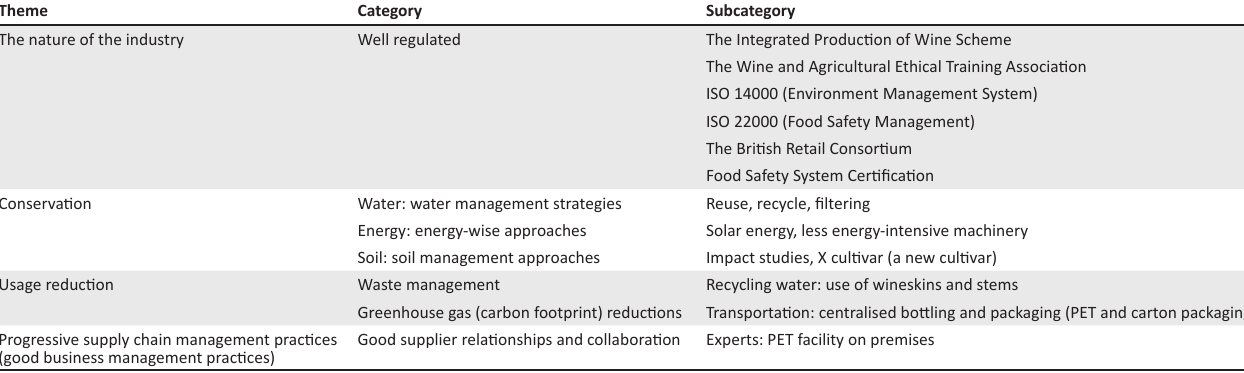
TABLE 1: Summary of themes, categories and